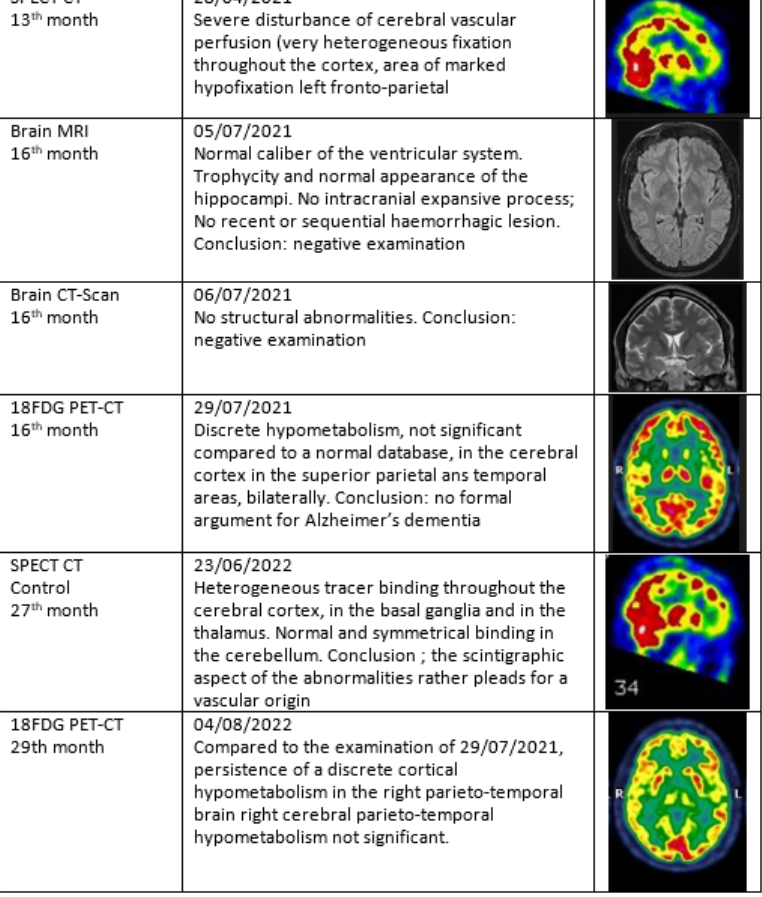
Figure 6. Case MGA 058, M, 49, senior executive. Acute COVID-19 on 1 March 2020. Persisting cognitive loss and exhausting fatigue, still off work after 27 months. Nuclear imaging shows its value in the follow-up of patients with PACS. Brain MRI and CT do not contribute in this case. First and second SPECT-CT highlights the vascular flow problem while 18FDG PET-CT provides information on the metabolism of the brain, although not considered significant here. (Images; courtesy of Dr Fabienne Richelle, St Luc Clinic, Bouge,